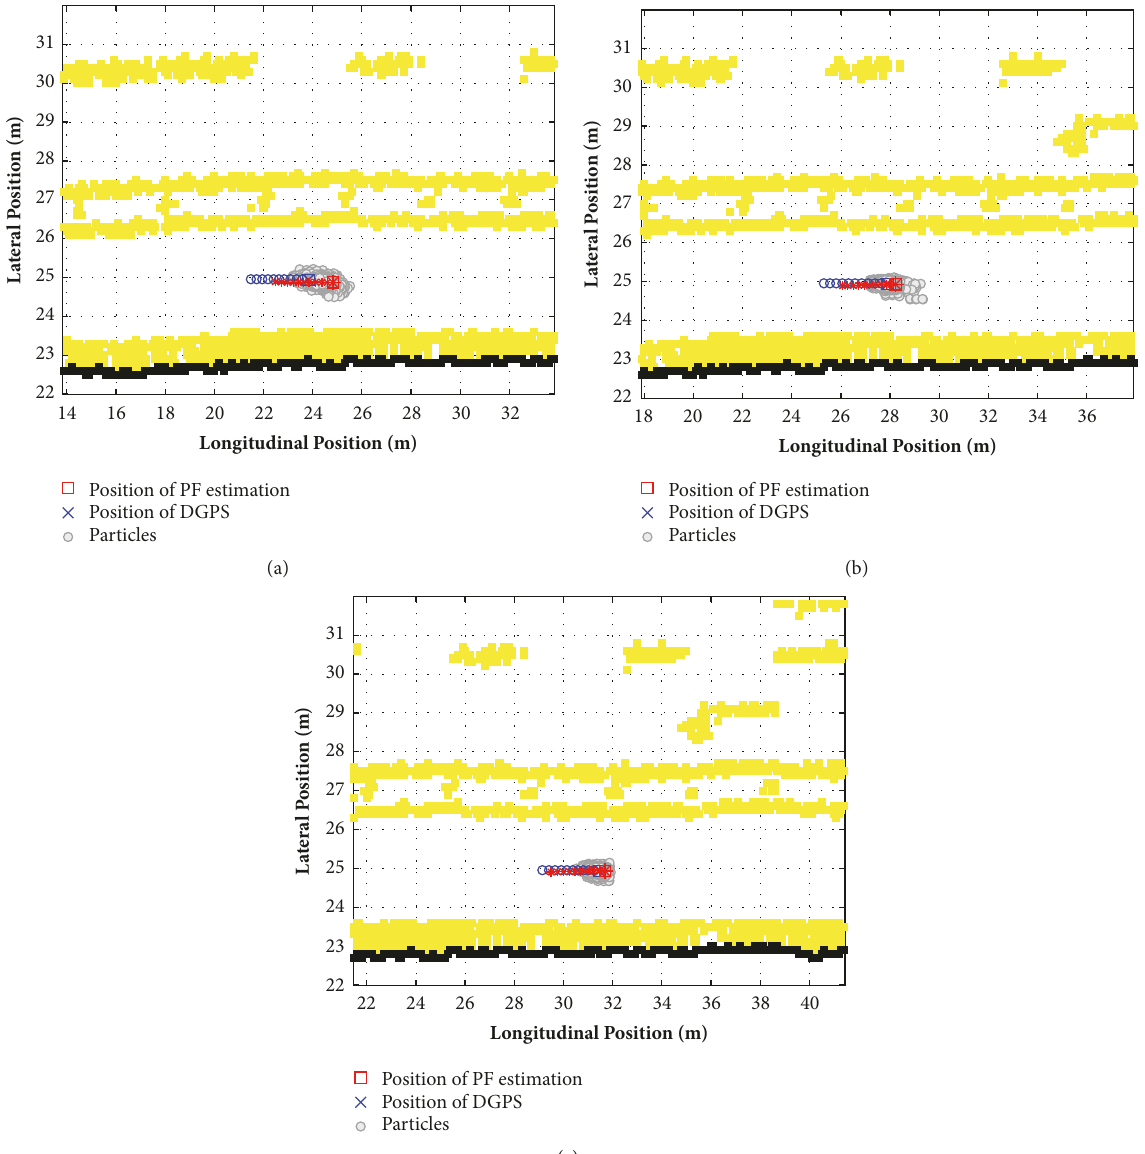
Figure 9: Convergence and divergence of particles according to road markings, obtained from three